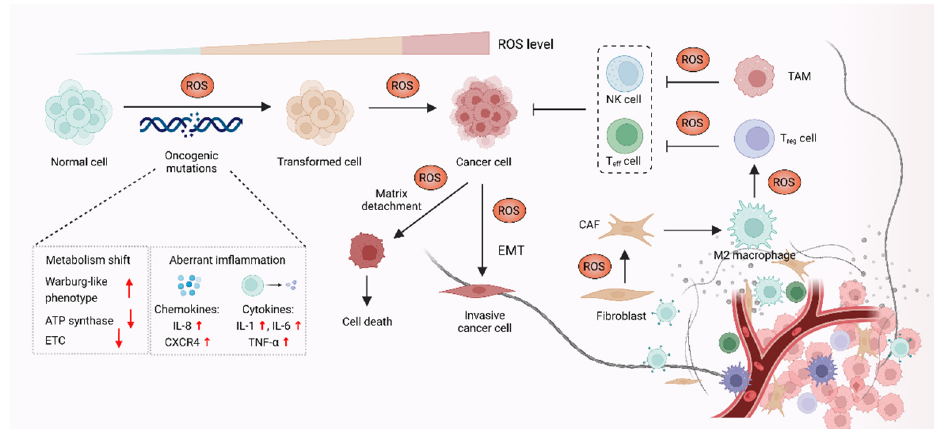
Figure 2. ROS promote carcinogenesis and malignant progression. In the process of carcinogenesis, ROS can contribute to DNA damage, which results in aberrant inflammation and metabolism, leading to oncogenic mutations and cell hyperproliferation. ROS can also act as signaling molecules to enable cancer cells’ survival and cancer progression via epithelial-to-mesenchymal transition (EMT). In addition, ROS might affect stromal cells, such as cancer-associated fibroblasts (CAFs), regulatory T (T reg ) cells, effector T (T eff ) cells and NK cells in the tumor microenvironment (TME) to promote cancer progression.